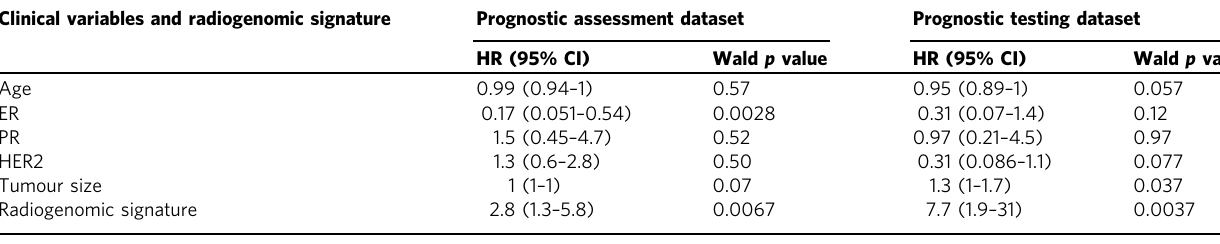
Table 3 Multivariate analysis of radiogenomic signatures and clinical variables. Clinical variables and radiogenomic